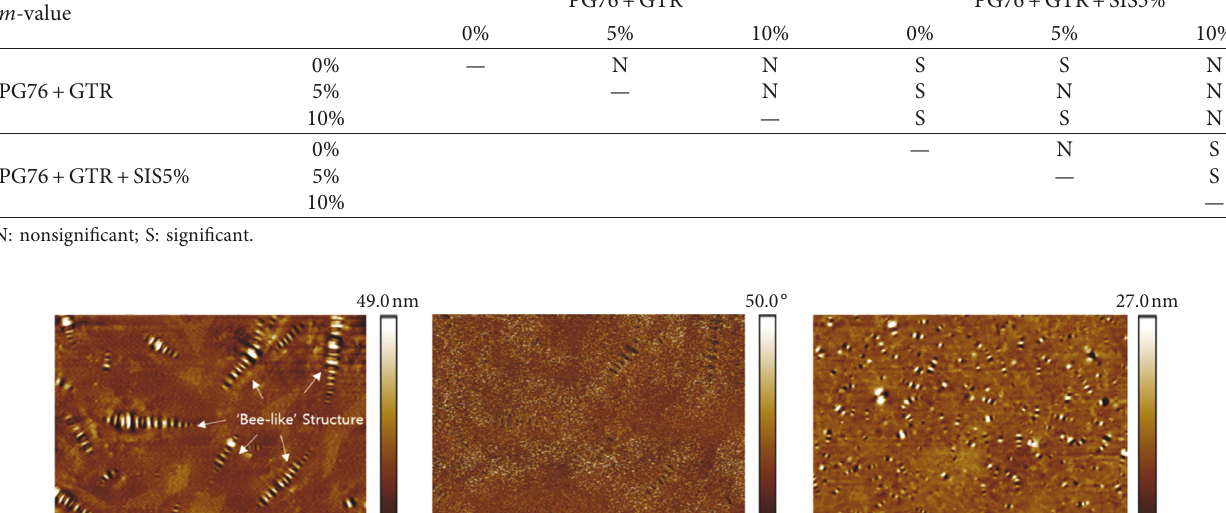
Table 8: Statistical analysis results of the m -value as a function of addition of SIS and GTR contents ( α � 0.05). m -value